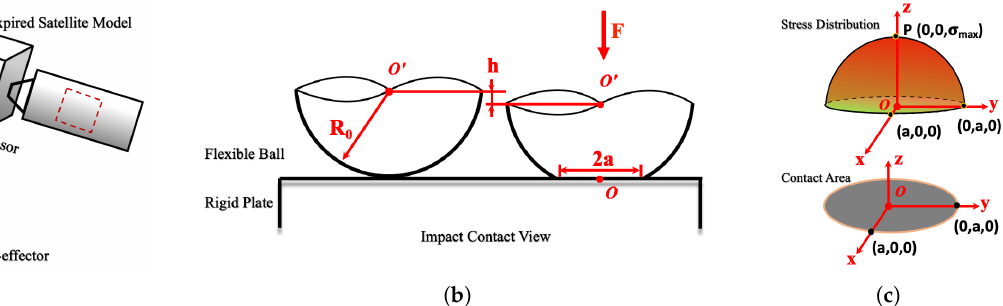
Figure 2. Contact model of mechanical detumbling. ( a ) Mechanical impulse detumbling mission. ( b ) Parameters of Hertz contact model. ( c ) Stress distribution and contact